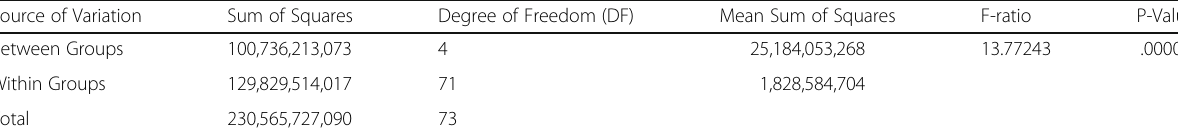
Table 7 Analysis of variance of income of respondents from different occupations in Yobe state Source of